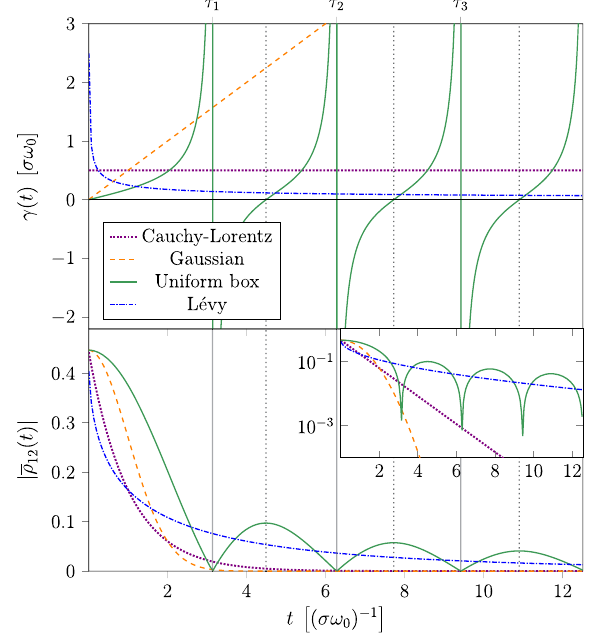
FIG. 2. Ensemble-average dynamics of a single qubit with t Þ , γ t Þ , spectral disorder. Top panel: Decoherence rates γ CL ð G ð γ t Þ for the Cauchy-Lorentz, the Gaussian, and the Lévy Le ð t Þ for distributions with coinciding scale parameters σ , and γ B ð the uniform box distribution, for visual clarity with 2 σ . Bottom panel: Decay of the coherences, i.e., of the off-diagonal terms of the average density matrix jh 1 j ¯ ρ ð t Þj 2 ij ¼ jh 2 j ¯ ρ ð t Þj 1 ij , for the four distributions. The initial state is mixed and chosen so as to ~b ~ σ have no particular symmetry: ρ ð 0 Þ ¼ ð 1 = 2 Þð 1 þ Þ , with the ~b initial Bloch vector ¼ ð 2 = 5 ; 4 = 5 ; 1 = 3 Þ , ~ σ ≡ ð σ x ; σ y ; σ z Þ , the vector of Pauli matrices, and the resulting initial coherence jh 1 j ¯ ρ ð 0 Þj 2 ij ≈ 0 . 43 . All four distributions lead to dephasing dynamics, as reflected by the Lindblad operators of the disorder master equation (28). The coherence revivals in the case of the uniform box distribution (green solid line) are manifestly in correspondence with the divergences, at times τ i (solid, vertical gray lines) and zeros (dotted, vertical gray lines) of the t Þ . Inset: Semilogarithmic plot showing decoherence rate γ B ð the decay of the coherence ’ s envelopes as exp ð − t Þ , exp ð − t 2 Þ , ffiffi p 1 =t , and exp ð − t Þ ,